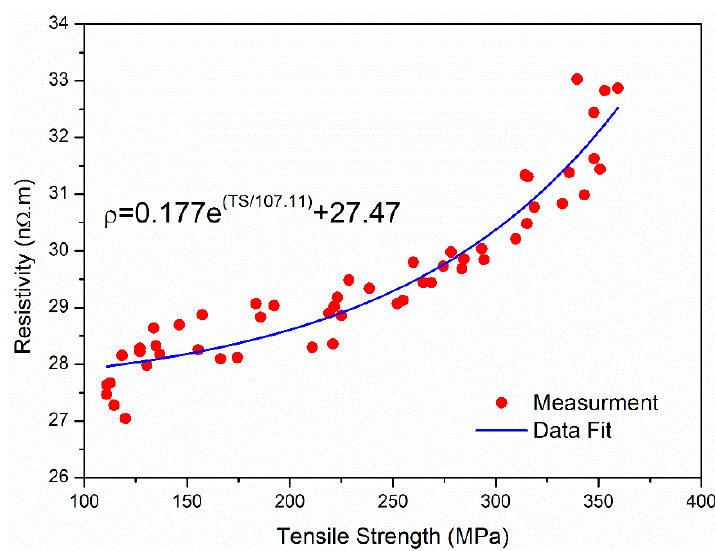
Figure 7. Relationship between electrical resistivity and tensile strength of 3.5 mm wires.